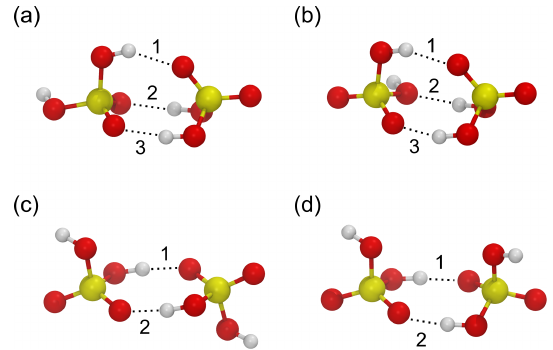
Figure 1. Four minimum energy structures for the sulfuric acid dimer (a–d) used to benchmark the force fields by Ding et al. (2003) and Loukonen et al. (2010) against ab initio calculations by Temelso et al. (2012). Sulfur atoms are yellow, oxygen atoms are red, and hydrogen atoms are white. Hydrogen bonds are indicated by dotted lines and enumerated according to Table 1.